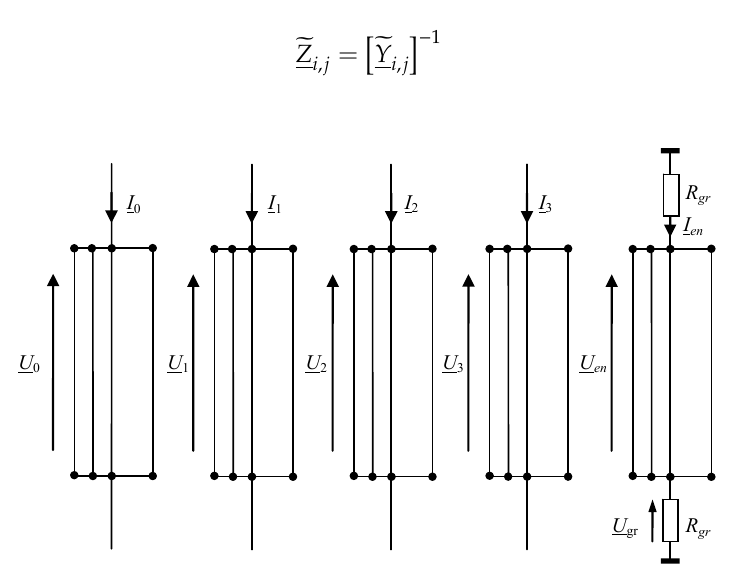
Figure 6. Circuit model of a high-current bus duct with a division of phase busbars, a neutral busbar, and a shield into elementary conductors in the case of shield grounding at its ends.